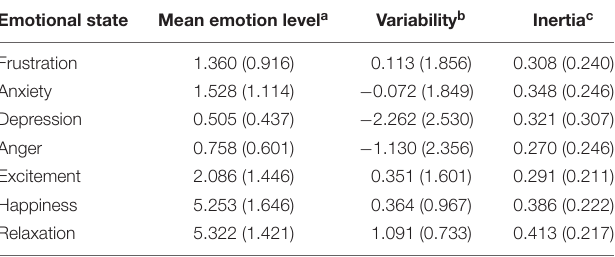
TABLE 1 | Descriptive statistics (mean and SD) of individual differences in mean levels, variability, and inertia of each emotional state. Emotional state Mean emotion level a Variability b Inertia